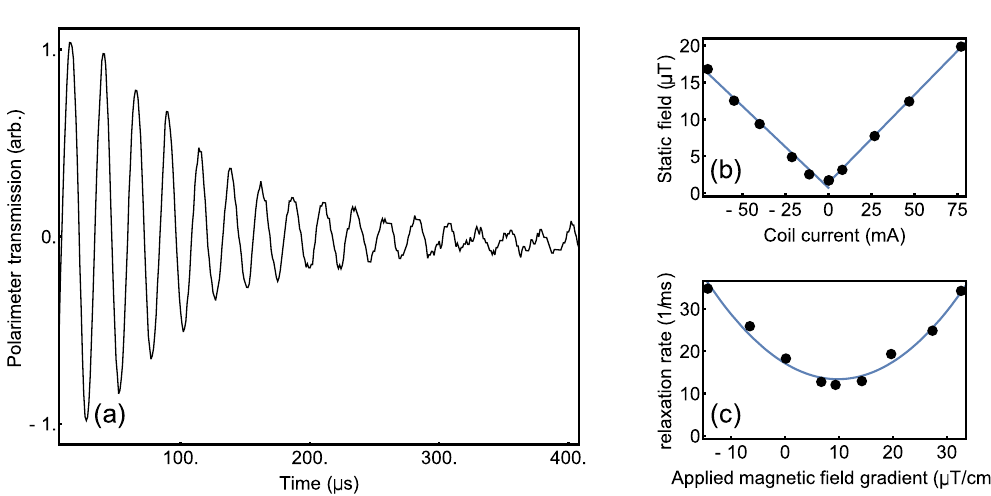
Figure 3. ( a ) Larmor precession measured from the GMOT. ( b ) The static field determined from the Larmor frequency is measured as a function of the Helmholtz coil current with best fitting lines applied. ( c ) The relaxation rate is measured as a function of applied magnetic gradient field with a best fitting